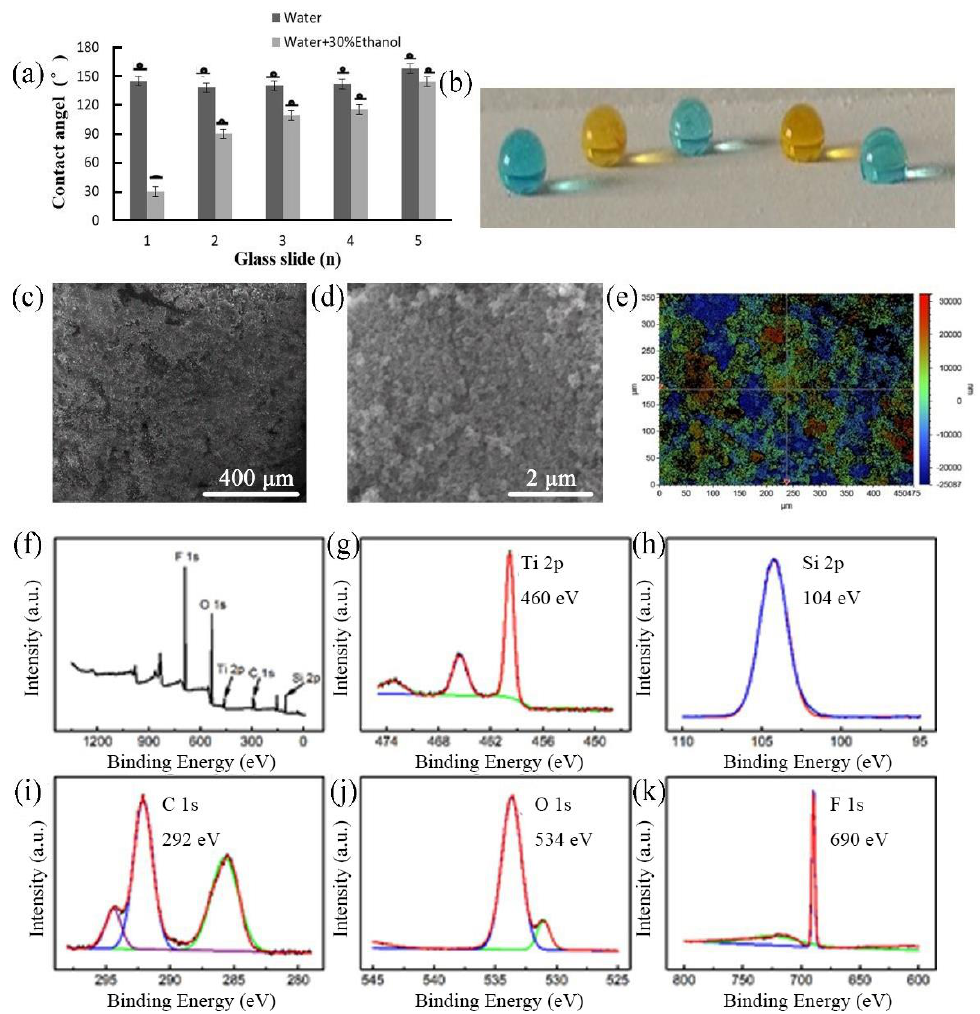
Figure 1. ( a ) Contact angles (CAs) of water and 30% ethanol on glass surfaces treated with various coatings: (1) 1% trichloro(1H,1H,2H,2H-tridecafluoro-n-octyl) silane (FOTS) + 1% nano SiO 2 ; (2) 1% FOTS + 1% tetraethyl orthosilicate (TEOS) + 3% TiO 2 ; (3) 1% FOTS + 1% nano SiO 2 + 3% TiO 2 ; (4) 1% FOTS + 1% nano SiO 2 + 1% TEOS; (5) 1% FOTS + 1% nano SiO 2 + 1% TEOS + 3% TiO 2 . ( b ) Images of the droplets of ethanol aqueous solutions on the quasi-superamphiphobic surface of Slide No. 5. Droplets (from left to right) of water, water + 10% ethanol, water + 20% ethanol, water + 30% ethanol, and water + 40% ethanol ( γ lv = 33.9 mN m − 1 ), showing gradually decreasing apparent contact angles on the quasi-superamphiphobic surface. ( c – d ) Scanning electron microscopy images showing the morphology of the optimal glass slide, Slide No. 5. ( e ) Roughness mapping with a R rms of 9.1 ± 0.1 µ m. ( f ) X-ray photoelectron spectroscopy (XPS) survey spectra of Slide No. 5. ( g – k ) XPS core level spectra of Ti 2p, Si 2p, C 1s, O 1s, and F 1s